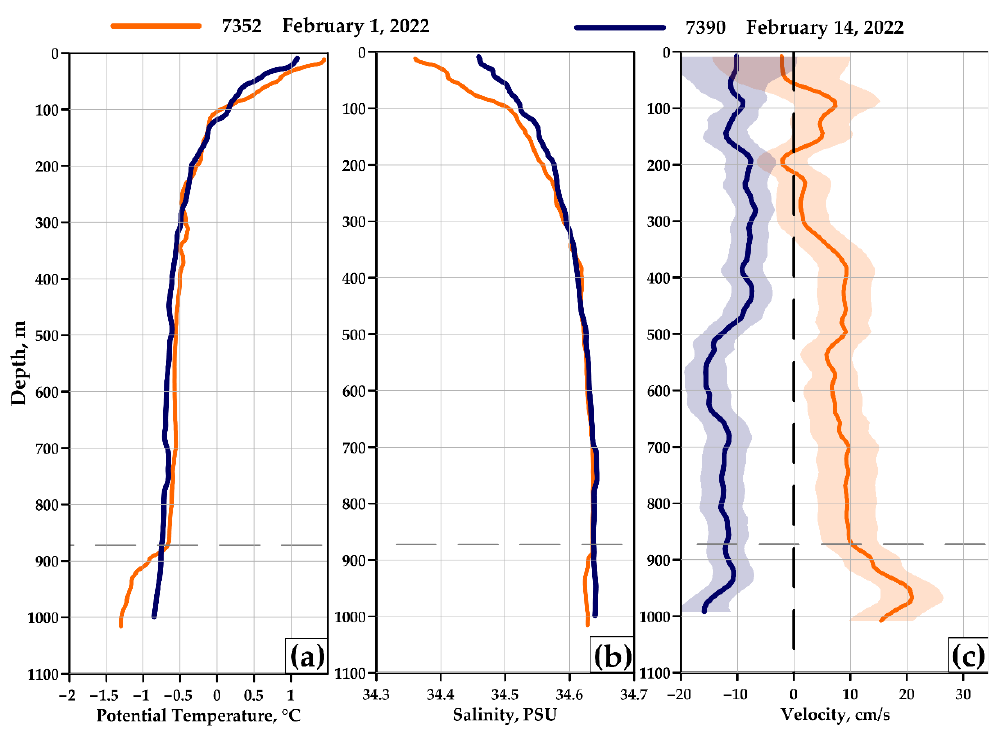
Figure 6. Measured LADCP velocities in the bottom layer over the sill point between the central and eastern basins of the BS. ( a , b ) Maximal velocities averaged ( c , d ) in the 50 m bottom layer and (( e , f )) the 100 m bottom layer. ( a , c , e ) Data measured on 1 February; ( b – f ) measurements performed two weeks later (on 14 February). The magnitude of currents is shown in both the colors and lengths of the arrows; all color and vector scales are the same in all panels. The relief is based on the GEBCO2021 database.